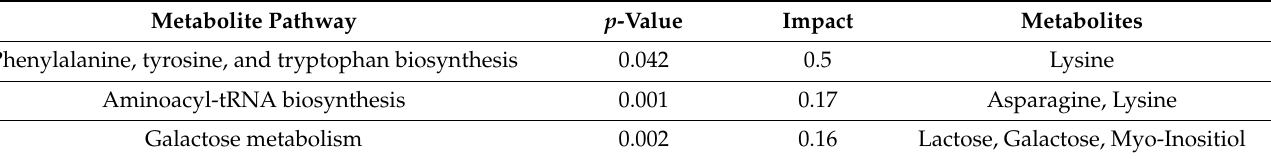
Table 2. List of potential metabolic pathways that change in serum according to heat